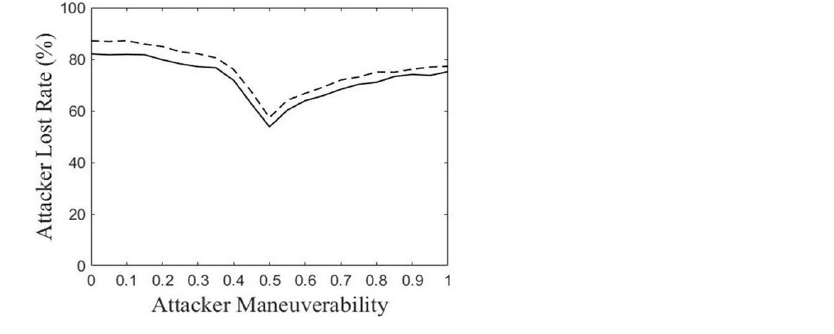
Figure 3. Attacker lost rate versus maneuverability, ———: p k = 0.6, − − − : p k =